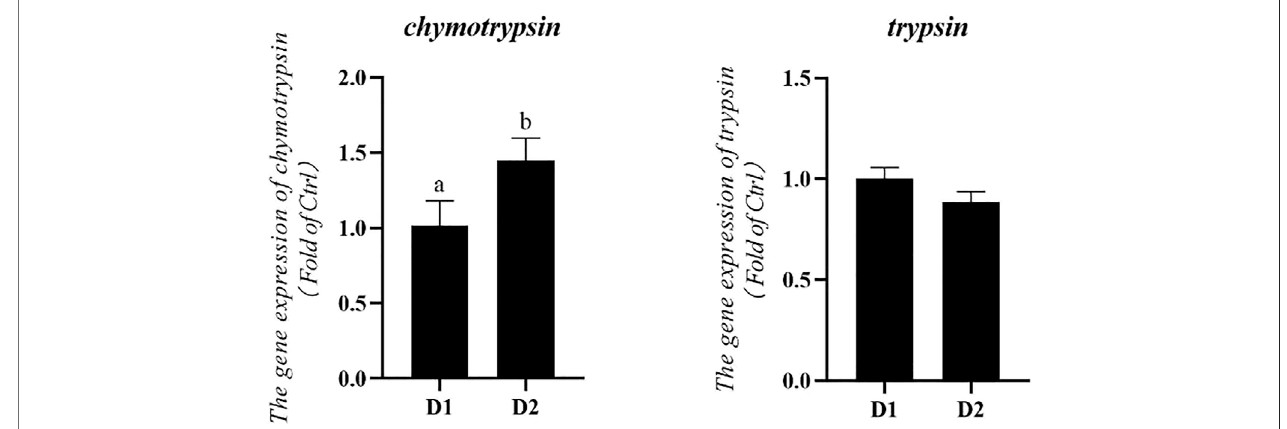
FIGURE3| Hepatopancreas mRNAlevels ofdigestiveenzymegenes of L. vannamei feddietsupplemented with/without H.pluvialis GXU-A23 for 56days.Values are mean ± SE ( n = 4). The small letters indicated signi fi cant differences at p < 0.05.